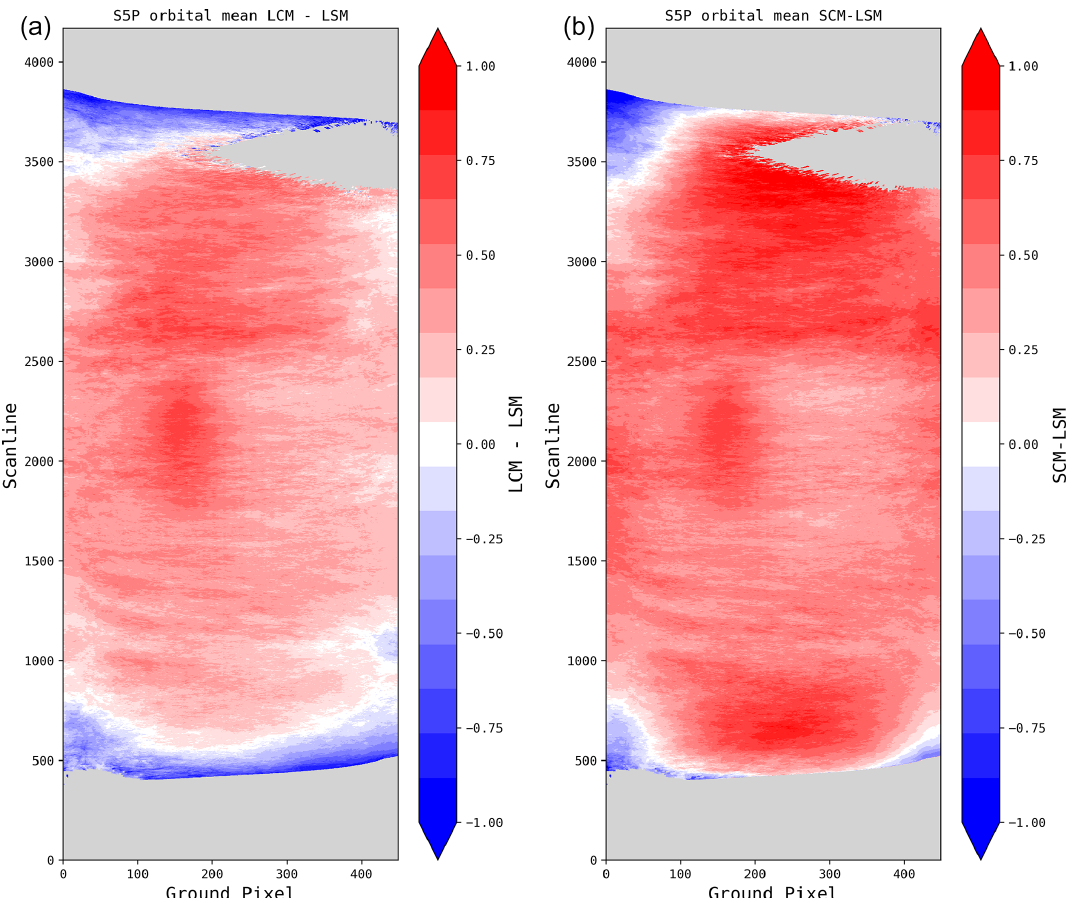
Figure 14. Mean difference in orbital distributions of TROPOMI AAI for the LCM (a) and the SCM (b) compared to the original LSM retrieval. Red indicates positive differences and blue negative differences.